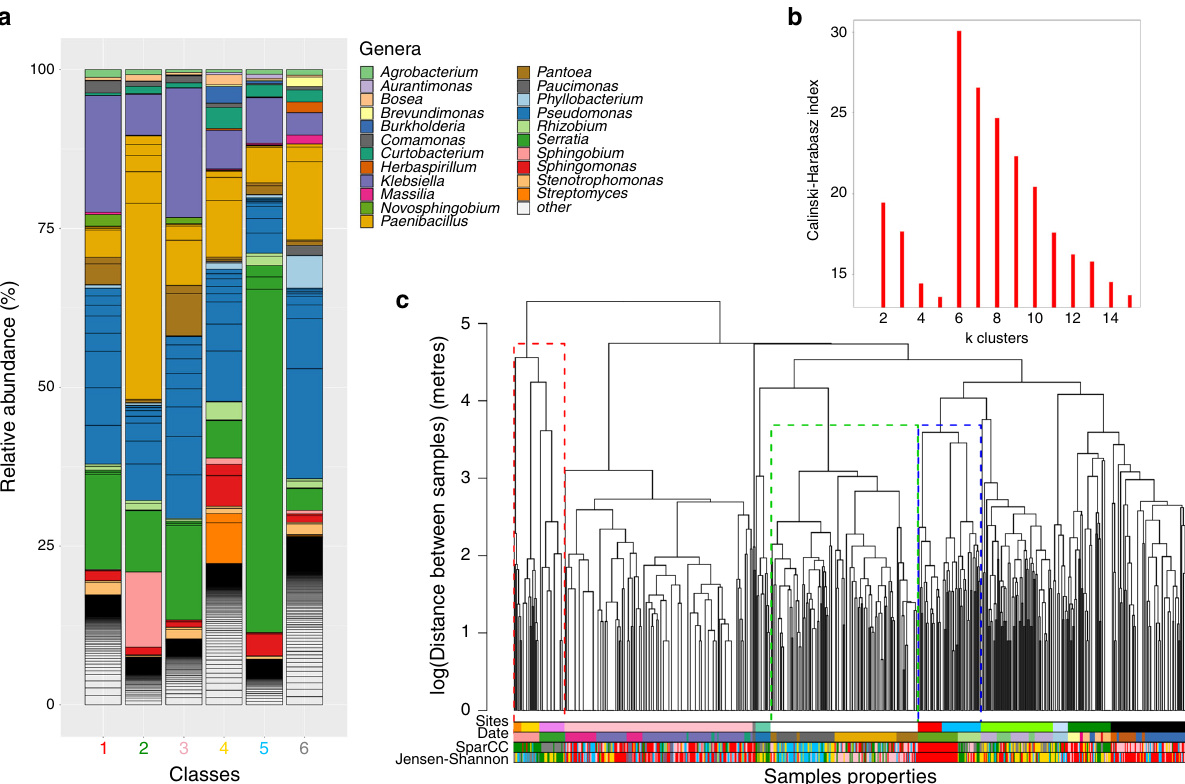
Fig. 2 Description of community classes and how they relate to the sampling sites. a Genus frequencies in each of the six community classes found after unsupervised clustering of the communities using D SparCC . Only the 15 most abundant genera in each community class are shown, with the remainder classi fi ed as others. b Calisnki – Harabasz index versus the number of fi nal clusters in the classi fi cation, showing a maximum at six classes. c The dendrogram represents the clustering of the samples (leaves in the tree) according to their spatial distances. The coloured bars represent membership of each sample to different classi fi cations (from top to bottom): the sites, the day of sampling collection (Date) and the classes found using either D SparCC and D JSD . Dotted rectangles in the dendrogram indicate examples of: (green) locations where one site was sampled on different days; (blue) two sites sampled on the same day: (red) a mix of both situations. It is apparent that the date is a better match to the community classes than the site, which is con fi rmed with a comparison between the classi fi cations (Supplementary Table